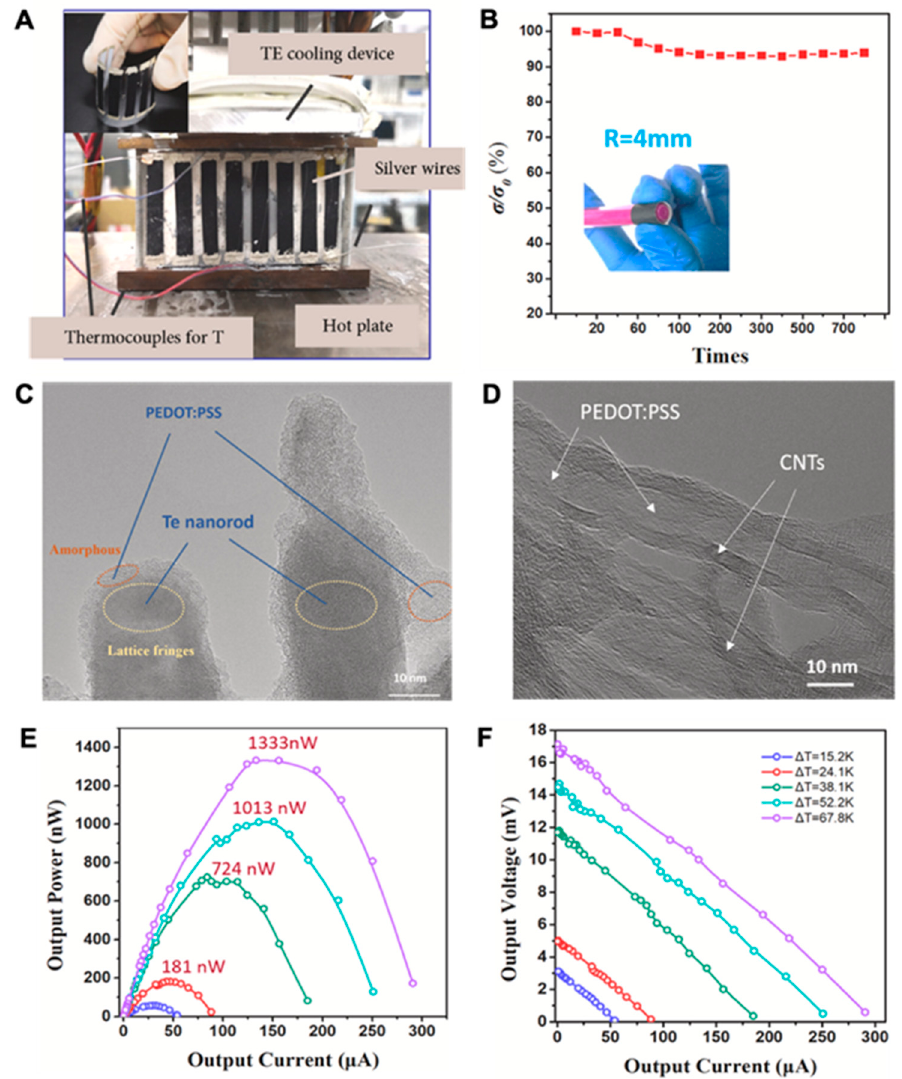
Figure 9. ( A ) the camera image of the thermoelectric device during testing; ( B ) the bending test of the device with 60% of CNTs; ( C ) the SEM image of PEDOT:PSS–Te; ( D ) the SEM image of